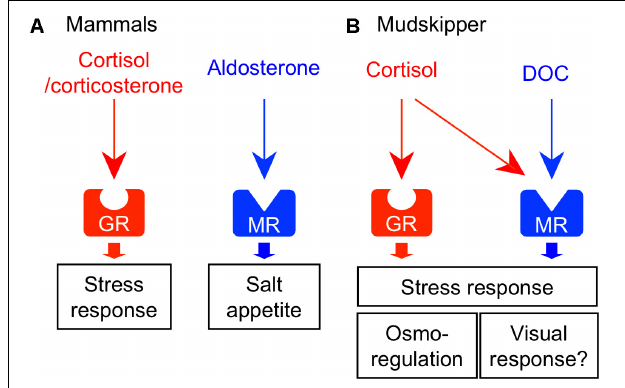
FIGURE 4 | Receptor-ligand interactions of corticosteroids and their central actions. (A) Corticosteroid system in mammals. Glucocorticoid (cortisol/corticosterone) and mineralocorticoid (aldosterone) activate their respective receptors – glucocorticoid receptor (GR) and mineralocorticoid receptor (MR). These corticosteroids act on the various brain regions and regulate homeostatic behaviors such as stress response and salt appetite. (B) Corticosteroid system in mudskippers. Cortisol-GR system mediates both glucocorticoid and mineralocorticoid functions. 11-deoxycorticosterone (DOC) is the preferred ligand for MR. In mudskippers, both MR and GR regulate the amphibious behavior related to a stress response. The aquatic preferences induced by GR and MR signaling may be related to osmoregulation and visual response,